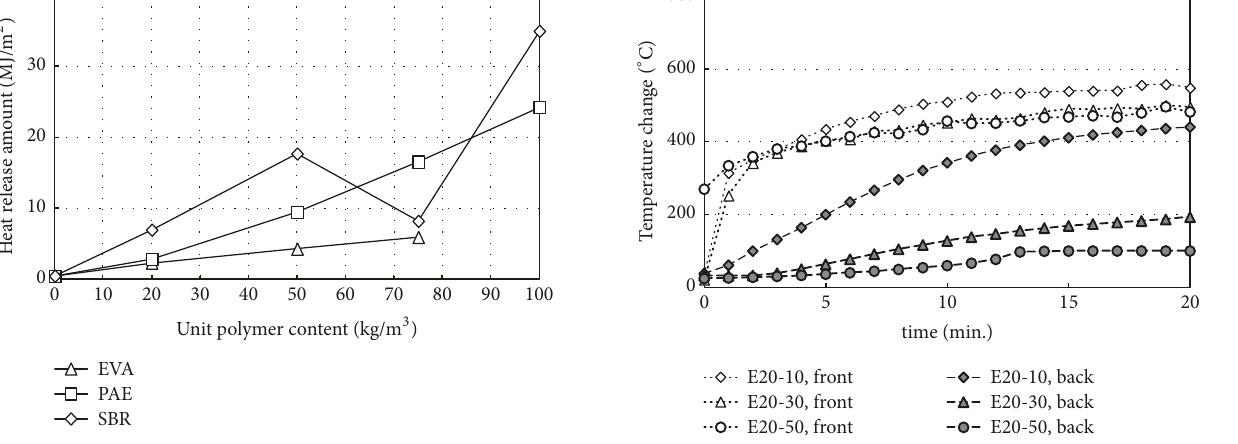
Figure 10: Temperature change inside and outside the specimen with specimen thickness.